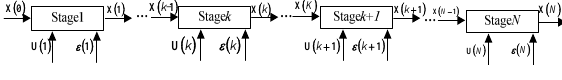
Fig. 1. Diagram of traditional multi station machining